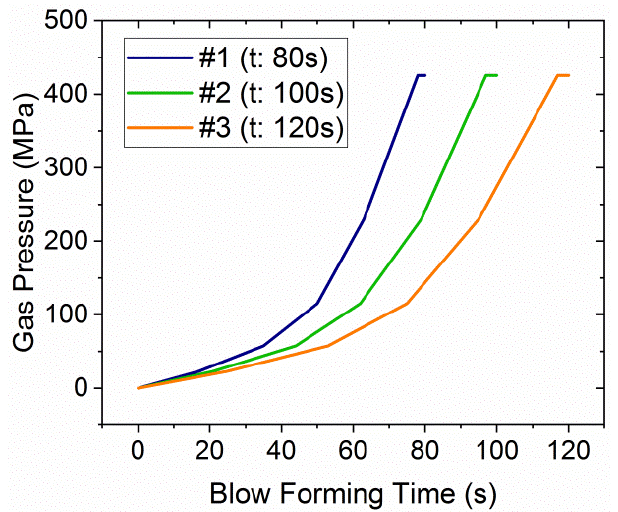
Figure 3. The gas pressure-time curves.